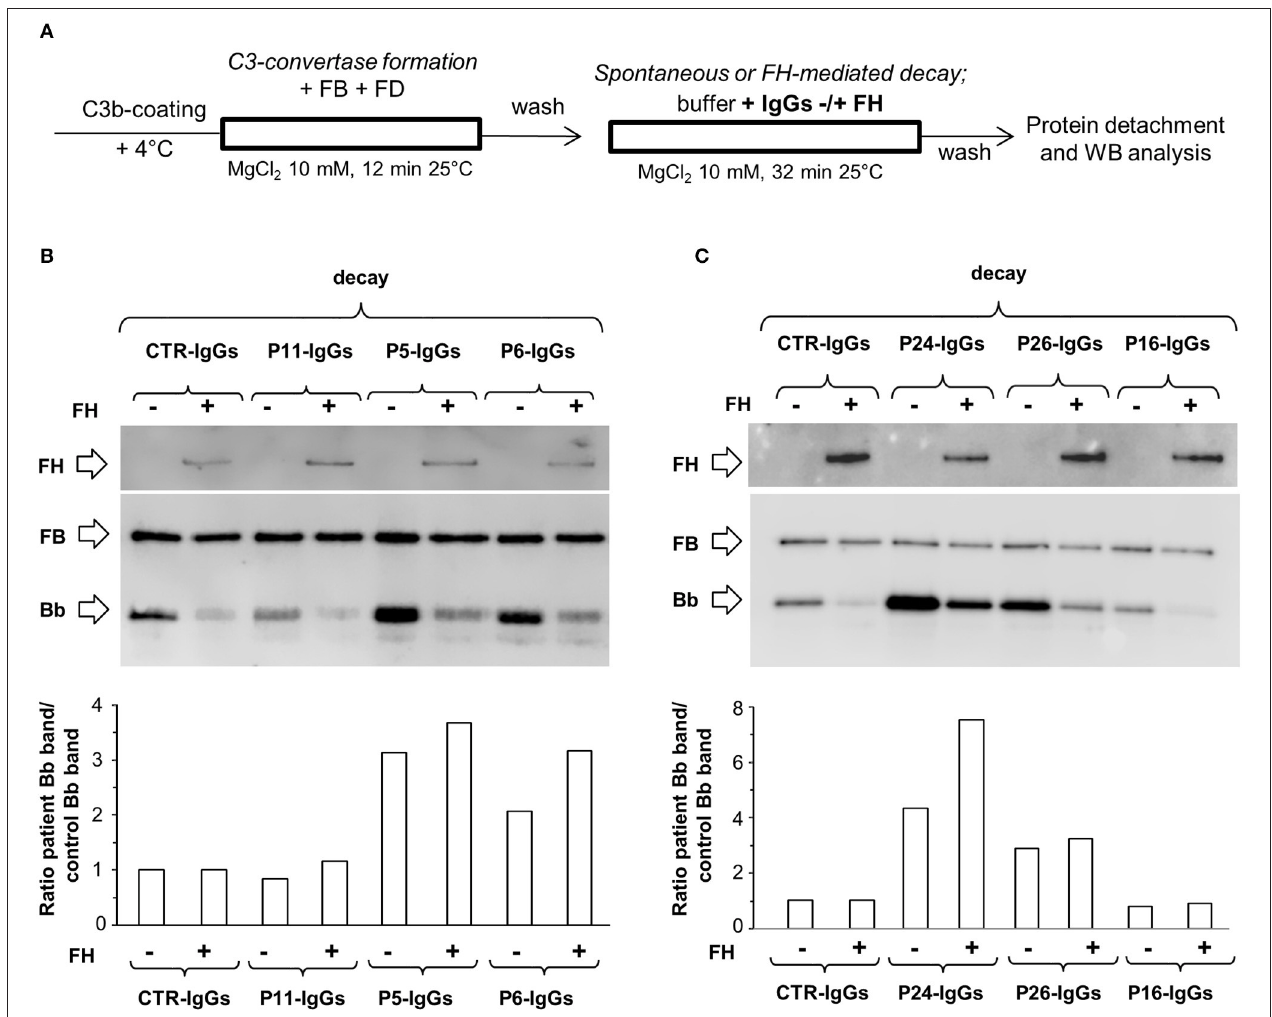
FIGURE 4 | Effect of patient and control IgGs on preformed C3bBb(Mg 2 + ) C3 convertase by microplate/Western blot (WB) assay. (A) Experimental design (protocol 2). (B,C) Representative images of the assay. C3bBb(Mg 2 + ) complexes were formed by incubating at 25 ◦ C for 12min C3b-coated wells with 1,000ng/ml FB, 10ng/ml FD, and 10mM MgCl 2 . The complexes formed were then incubated in the presence of 100 µ g/ml IgGs from patients or healthy controls without (spontaneous decay, decay –) or with (FH-mediated decay, decay + ) 2,640ng/ml FH. The C3NeF IgG C3 convertase-stabilizing activity was quantified as the ratio of the densities (in Pixel 2 ) of Bb bands (visualized by an anti-FB antibody) after decay in the presence of patient IgGs/ Bb band after decay in the presence of control IgGs (ratio patient Bb band/control Bb band) and results are reported in the bottom graphs. The membranes were then incubated with an anti-FH antibody and FH band could be visualized at 150 KDa (top). Results of a representative microplate/WB experiment of n = 3 for each sample are